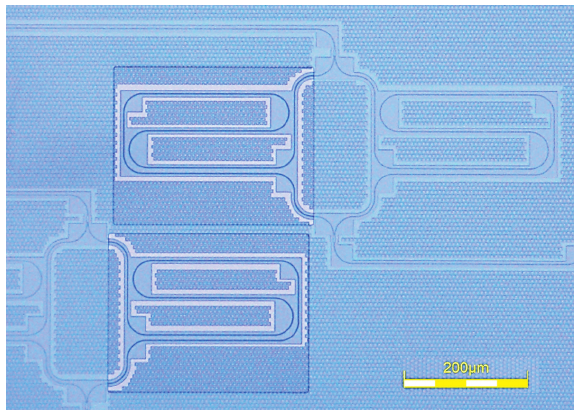
Figure 9: Microscopy picture of two MZIs. The arms are curled up to reduce the footprint of the